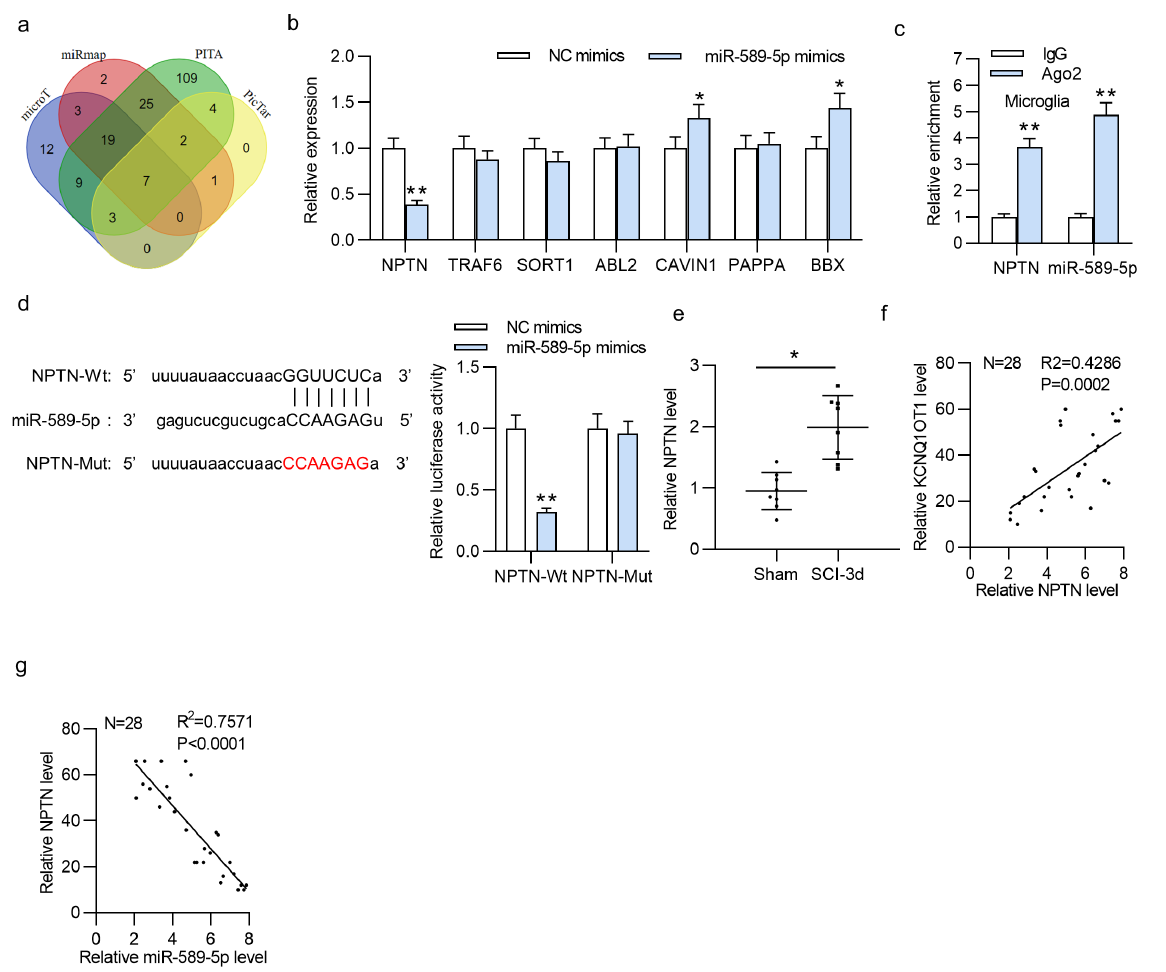
Figure 4. NPTN was a target of miR-589-5p. (a) Bioinformatics analysis was performed to find the potential targets of miR-589-5p. (b) The expression of the candidate mRNAs upon miR-589-5p mimics was detected by RT-qPCR. (c) RIP indicated the enrichment of miR-589-5p and NPTN in Ago2 and IgG group. (d) The potential binding site between NPTN and miR-589-5p was exhibited. Luciferase reporter assay showed miR-589-5p bound with NPTN. (e) NPTN level in spinal cord tissues. (f-g) Pearson’s correlation analysis showed the correlation between NPTN and miR-589-5p as well as NPTN and KCNQ1OT1. * p < 0.05. ** p <